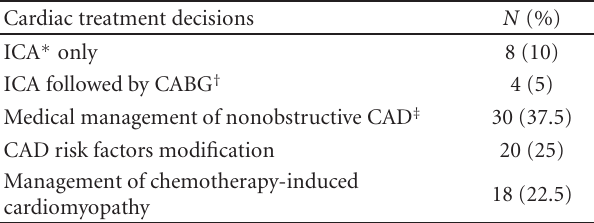
Table 5: Cardiac treatment decisions based on cardiac computed tomographic angiography findings.